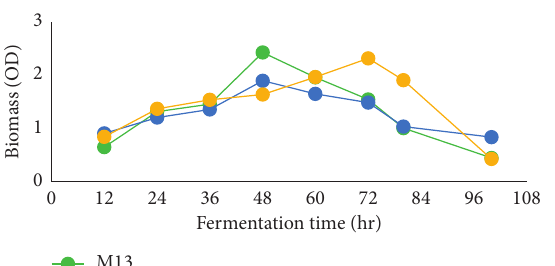
Figure 7: Cell growth with respect to different incubation periods.